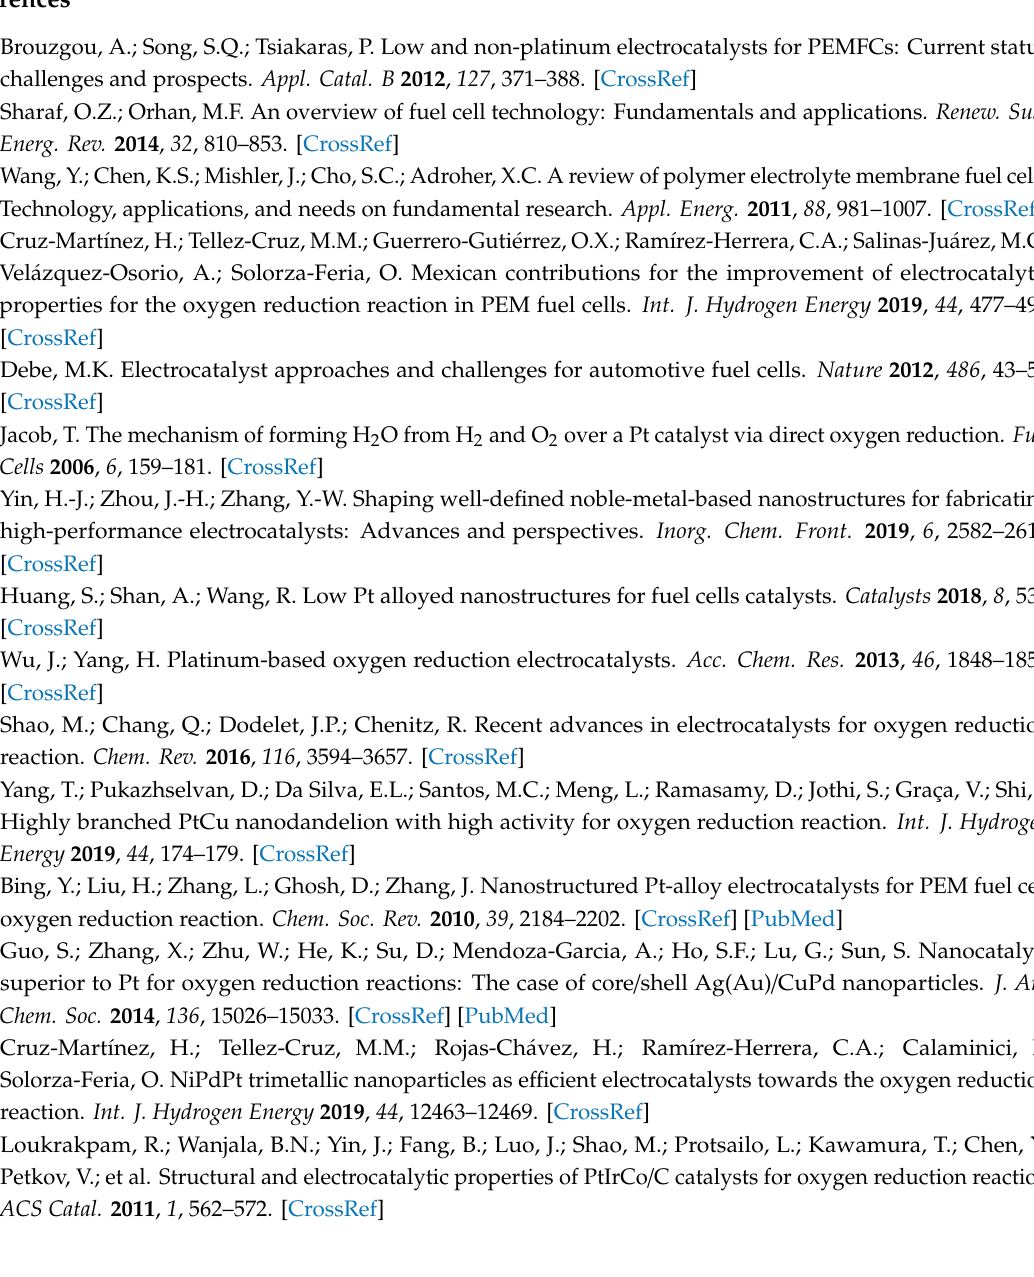
initial and after 5000 CVs obtained at 1600 rpm with a scan rate of 20 mV s − 1